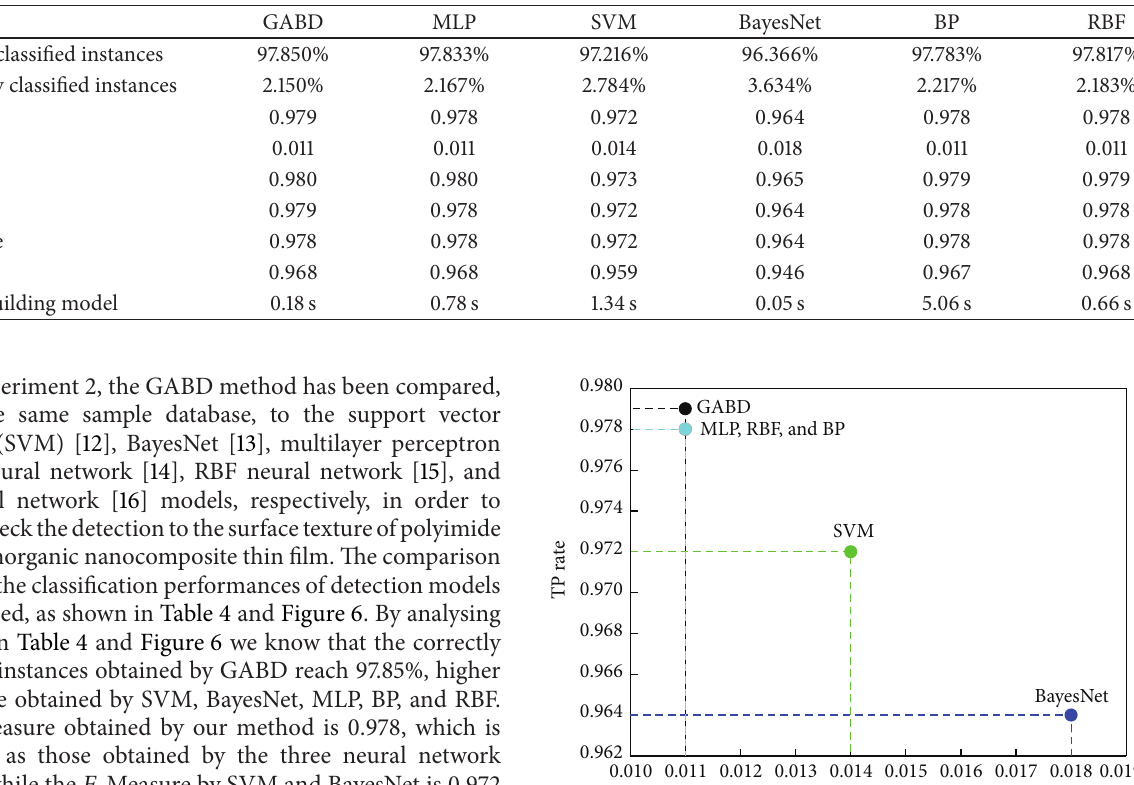
Table 4: The comparison of performance.